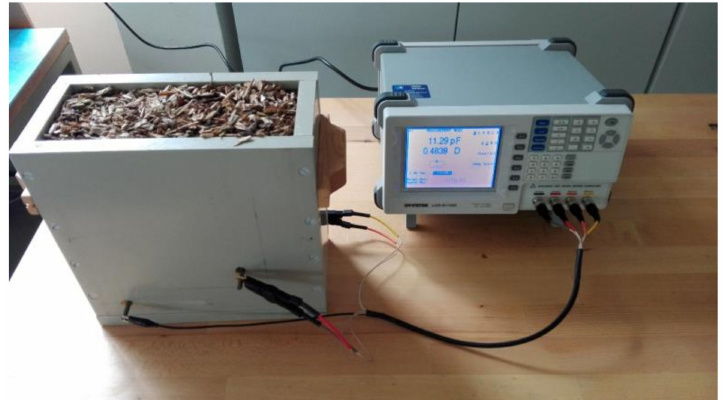
Figure 2. Connections between the measuring box and GW Intec 811G LCR meter for the measure- ment of the dielectric properties of wood